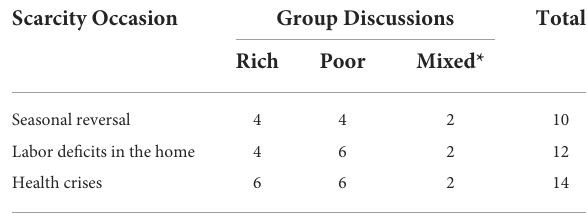
TABLE 2 Situations of food scarcity reported by socioeconomic